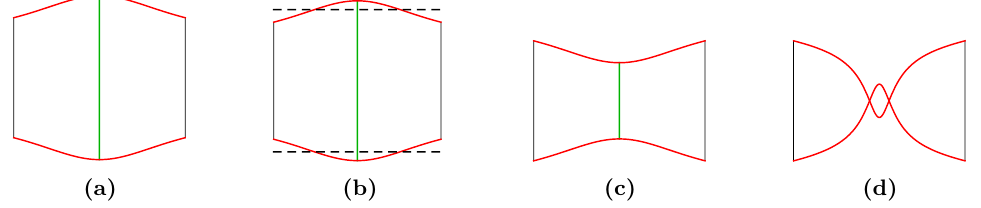
Figure 6. Four types of disk-brane configurations studied in this paper: (a) disconnected positive-tension branes, (b) intersecting positive-tension branes obtained by cutting and gluing along the dashed black lines, (c) disconnected negative-tension branes, and (d) intersecting negative-tension